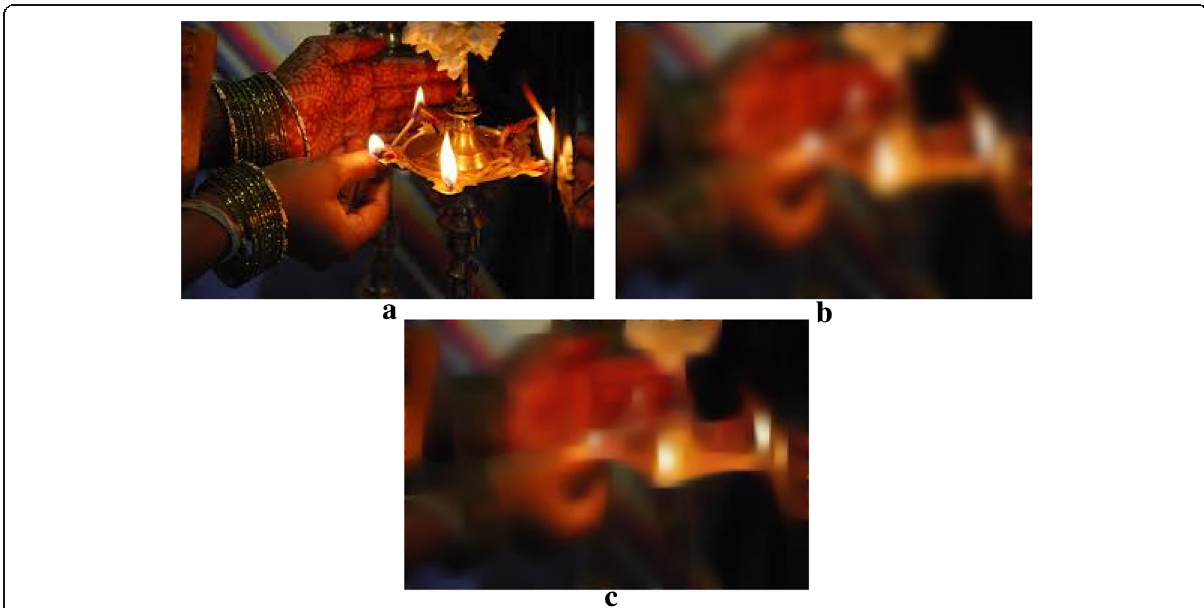
Fig. 9 Anisotropic smoothing of lamp image for n = 25. a Original image, b PM ( λ = 0.25), and c FORADF ( λ = 1). λ represents the control parameter, and n represents the number of iterations. The results are given to demonstrate the superiority in anisotropic behavior of the proposed FORADF in comparison with the benchmark Perona-Malik anisotropic diffusion